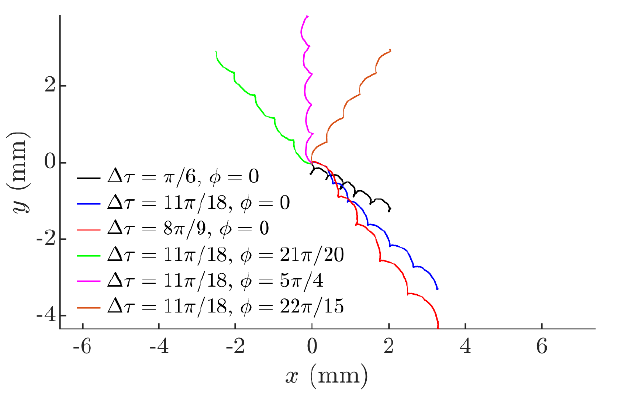
Figure 11. Captured experimental trajectories of the part when A e = 0.28 mm, ω = 62.8 rad/s, ε = π /2.